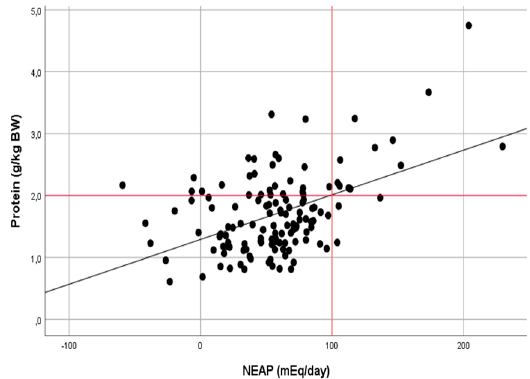
Figure 2. Relationship between the dietary protein intake (g • kg − 1 • day − 1 ) and NEAP (mEq • day − 1 ) in athletes of anaerobic sports (r = 0.482, p < 0.001) .